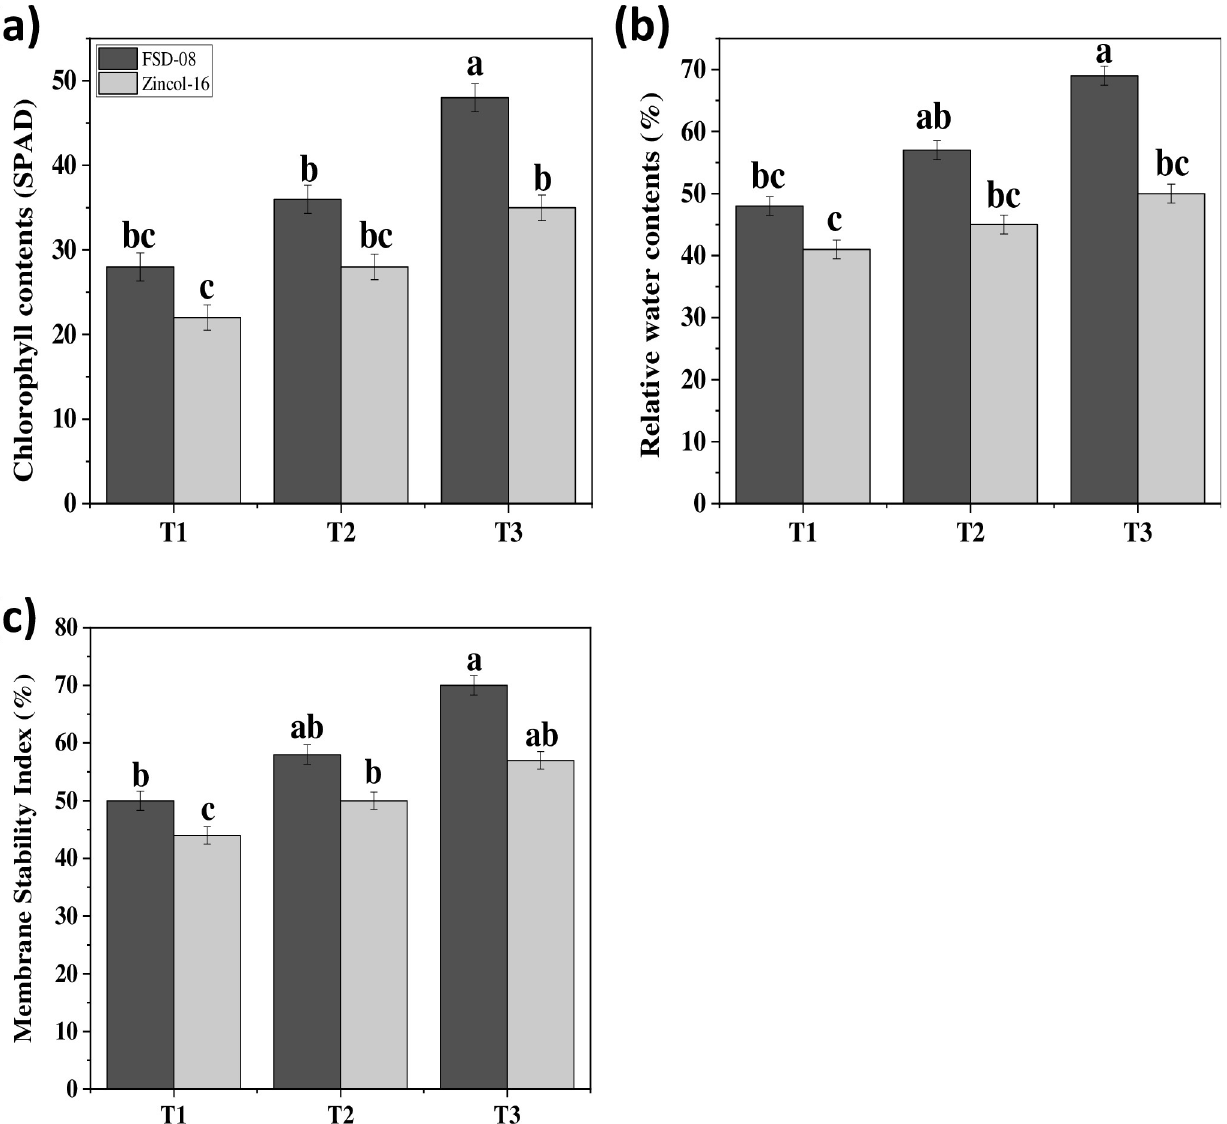
Fig 1. The effect of exogenous caffeic acid supply on chlorophyll contents (a), relative water contents (b) and membrane stability index (c) of two wheat ( Triticum aestivum L.) varieties subjected to salt stress. The bar values depict the average of three replications and the bars not sharing the same lowercase letters differ significantly from each other according to the HSD test at P < 0.05 probability. Treatments include (T 1 ) Saline field EC 8.7 dS m -1 , (T 2 ) saline field + 50 μ M caffeic acid, (T 3 ) saline field + 100 μ M caffeic acid.